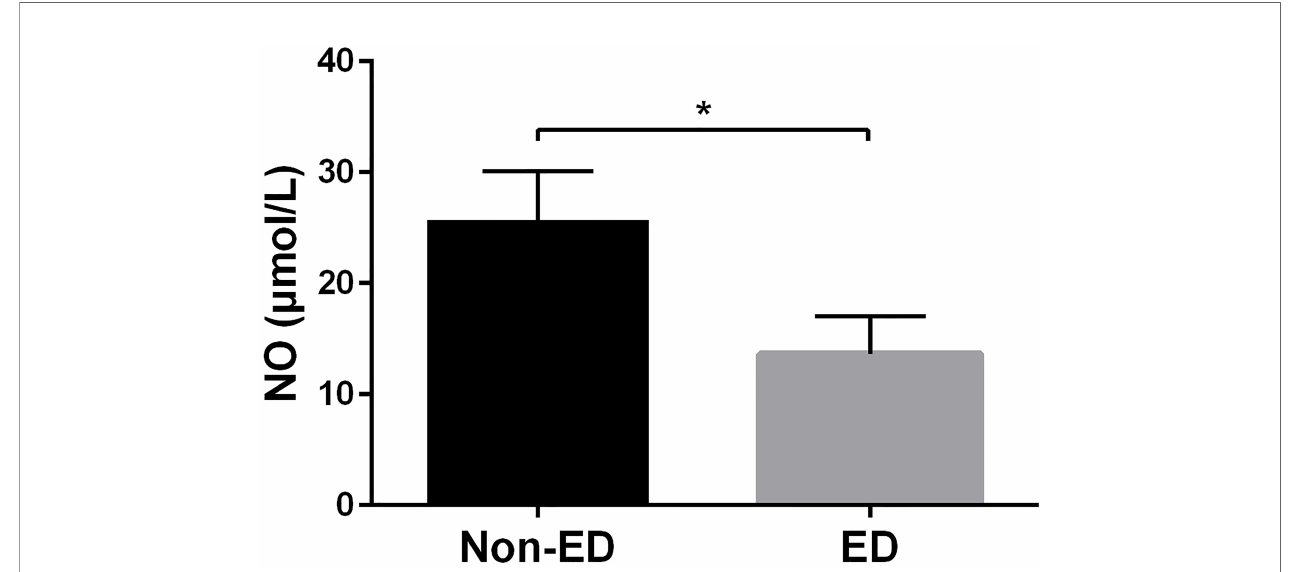
FIGURE 3 | NO levels were signi fi cantly decreased in patients with ED. Patients with ED had signi fi cantly lower NO levels than non-ED patients (9.15 [5.58-22.48] m mol/L vs 16.50 [12.33-31.78] m mol/L, p = 0.012). * means p-value < 0.05.